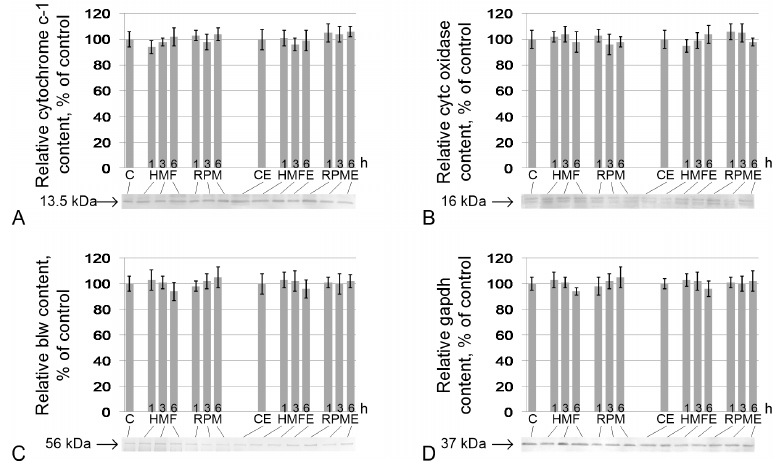
Figure 4. Relative contents of proteins that participate in cell respiration. ( A ) cytochrome c -1 (CG4769) (13.5 kDa), protein of the respiratory chain, located between complexes III and IV; ( B ) cytochrome c oxidase (CG10396) (16 kDa), protein of complex IV of the respiratory chain; ( C ) blw (bellwether), ATP synthase F1 (56 kDa), subunit of ATP synthase; ( D ) gapdh, glyceraldehyde-3-phosphate dehydrogenase (37 kDa), catalyzes one step of the glycolytic breakdown of glucose. Typical western blots for each protein are shown under the according